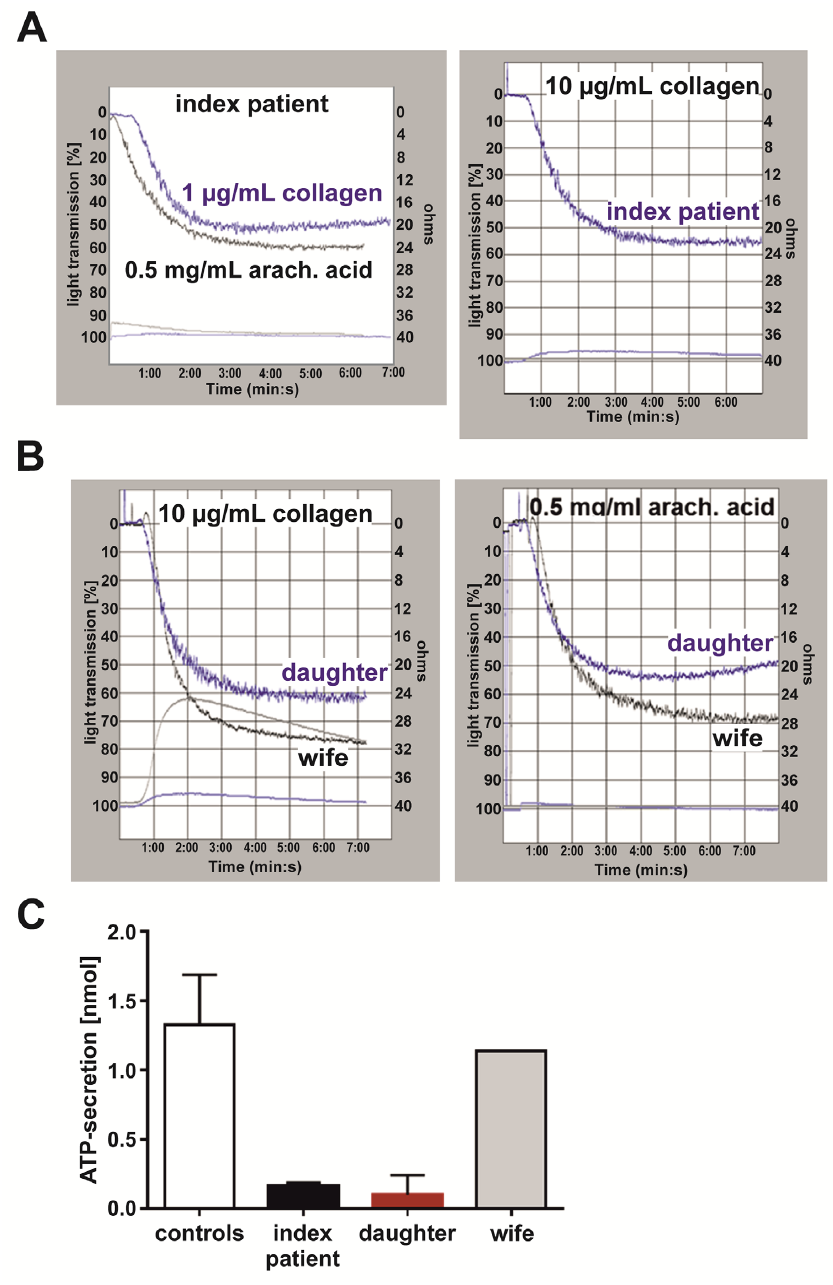
Figure 3. Simultaneous platelet aggregation and δ -granule ATP secretion capacity (index patient, daughter, and wife) induced by collagen and arachidonic acid. Platelets in platelet-rich plasma were adjusted to 2 × 10 8 /mL with autologous platelet-poor plasma, and simultaneous platelet aggregation and ATP secretion induced by collagen and arachidonic acid were monitored for 8 min by lumi- aggregometry. ( A ) Representative platelet aggregation (top curves, right y -axis light transmission (%)) and ATP release (bottom curves represent bioluminescence signals) of ( A ) index patient induced by 1 µ g/mL, 10 µ g/mL, and 0.5 mg/mL arachidonic acid, and ( B ) index patient’s daughter and wife (day control) induced by 10 µ g/mL collagen and 0.5 mg/mL arachidonic acid, respectively. ( C ) Quantitation of platelet-secreted ATP in nmol for the index patient (black; n = 3, collagen (1 µ g/mL, 10 µ g/mL), arachidonic acid (0.5 mg/mL)), his daughter (red; n = 2, 10 µ g/mL collagen, 0.5 mg/mL arachidonic acid), his wife (grey; n = 1, 10 µ g/mL collagen), and healthy adult controls (white, n = 30, 10 µ g/mL collagen, 0.5 mg/mL arachidonic acid). Data with n ≥ 2 are presented as mean ±